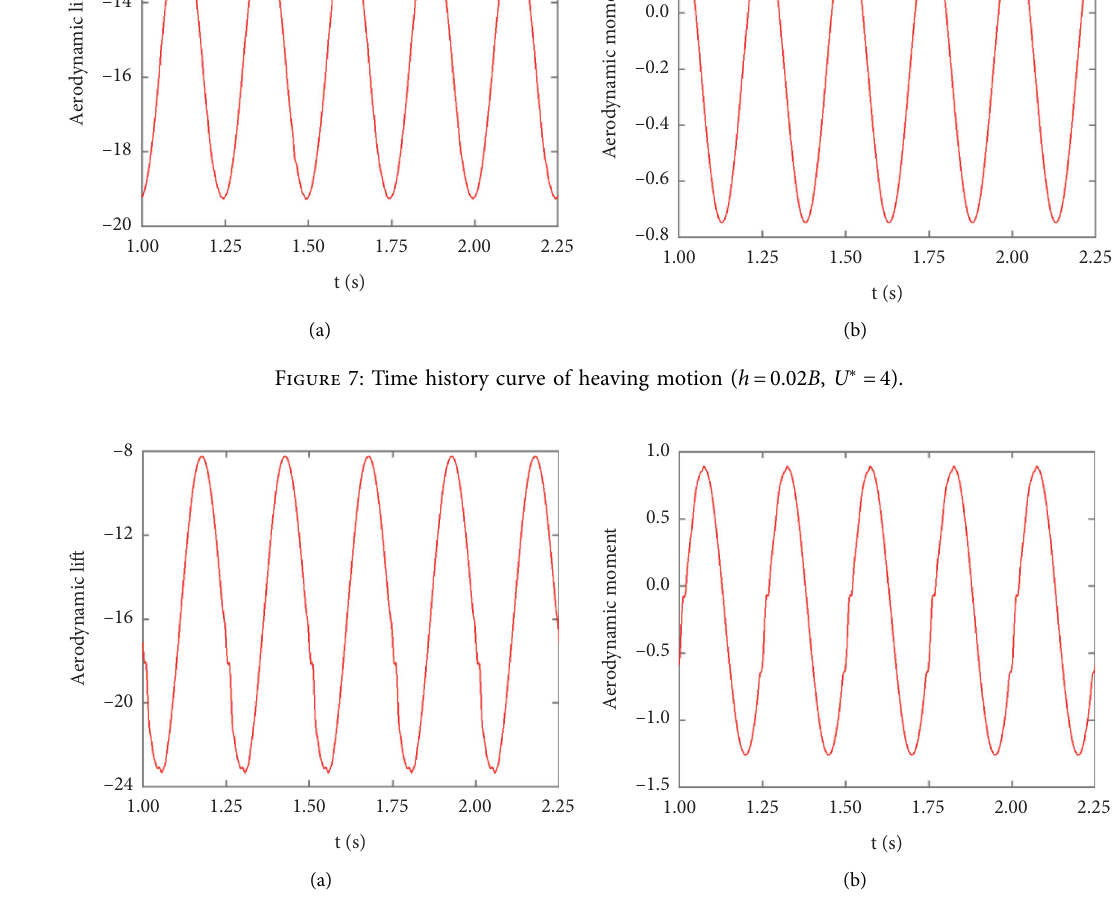
Figure 8: Time history curve of pitching motion ( α � 2 ° , U ∗ � 4).